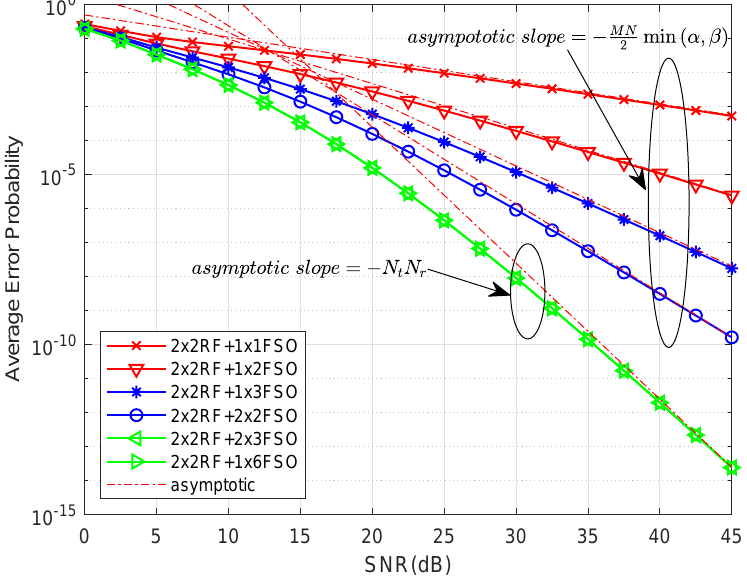
Figure 5. BER of MIMO mixed RF/FSO